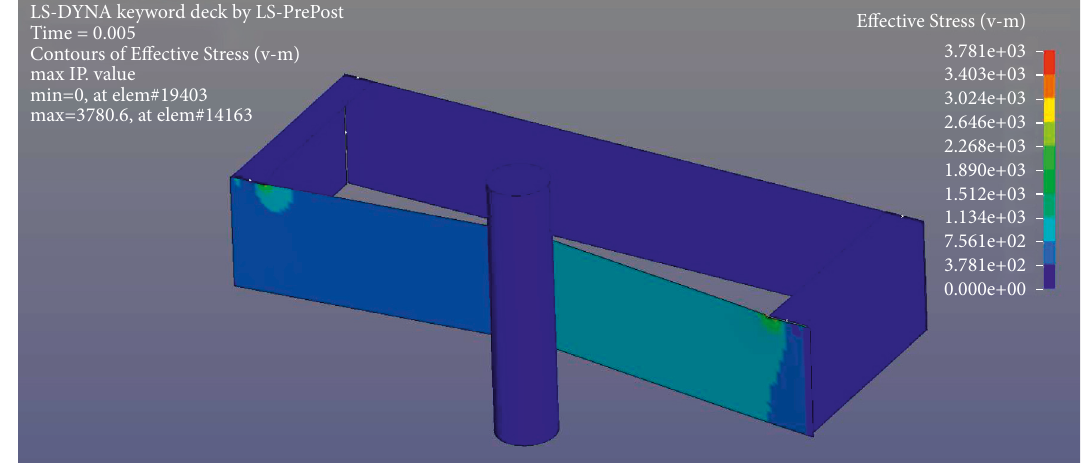
Figure 14: von Mises stress.